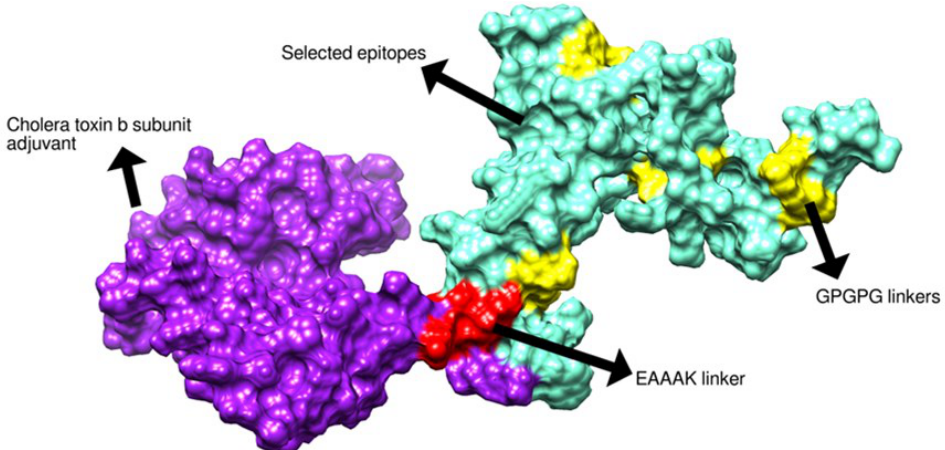
Figure 5. Three-dimensional structure of designed vaccine. Table 3. Pairs of amino-acid residues Chi-3 values and